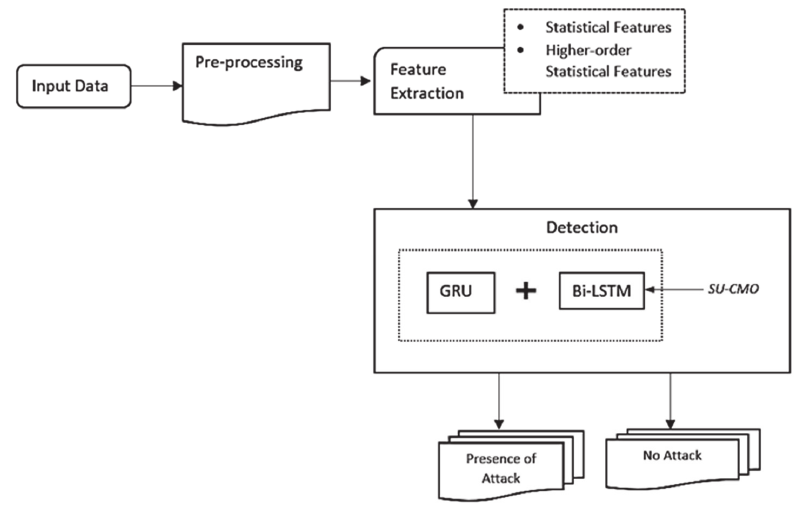
Figure 1. The overall framework of the adopted model.